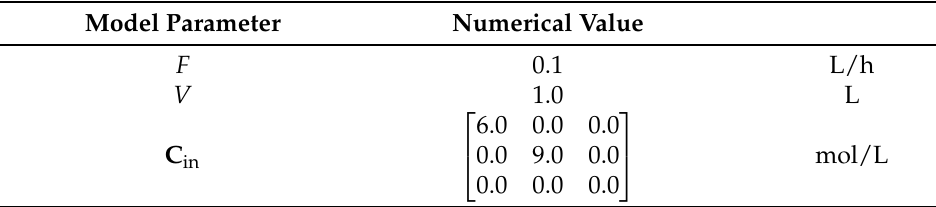
Table 1. Model parameter values.